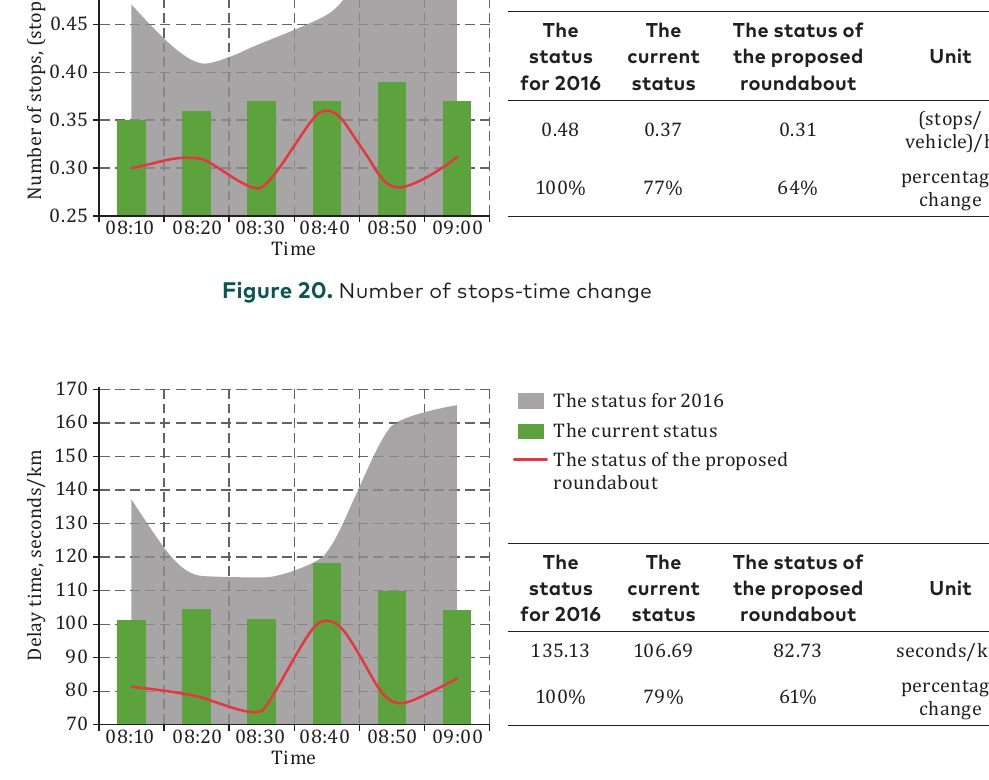
Figure 21. Vehicle delay time change